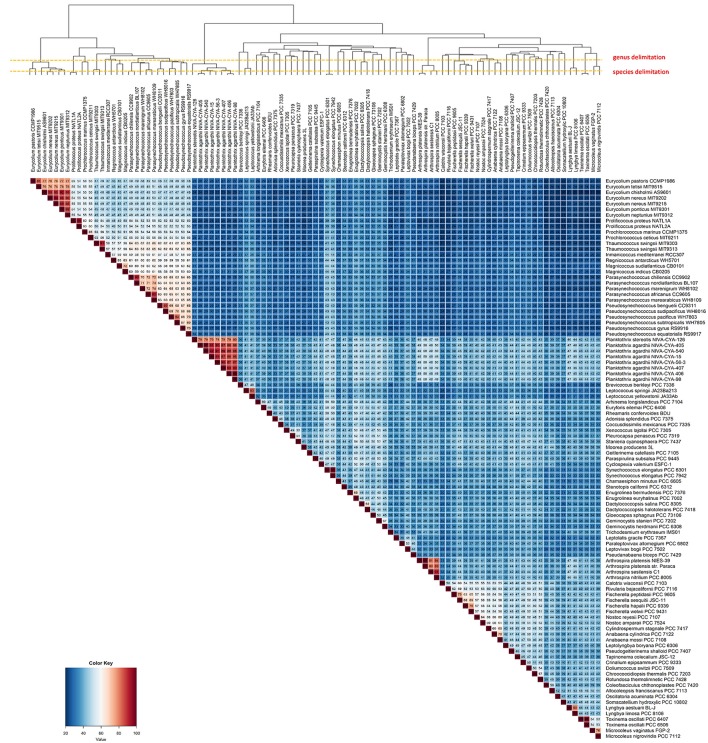
Heatmap displaying the AAI levels between cyanobacterial genomes. The intraspecies limit is assumed as ≥95%, whereas genera delimitation is assumed as ≥70% (dashed lines) AAI. Clustering the genomes by AAI similarity was done using a hierarchical clustering method in R (hclust), based on Manhattan distances. The AAI values are associated with the respective thermal color scale located at the bottom left corner of the figure. The proposed new genera and species names were adopted in this figure.